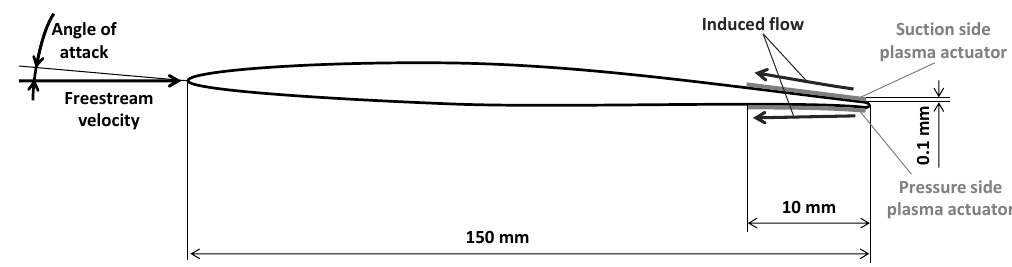
Figure 4. Sketch of the blade section with the modeling of plasma